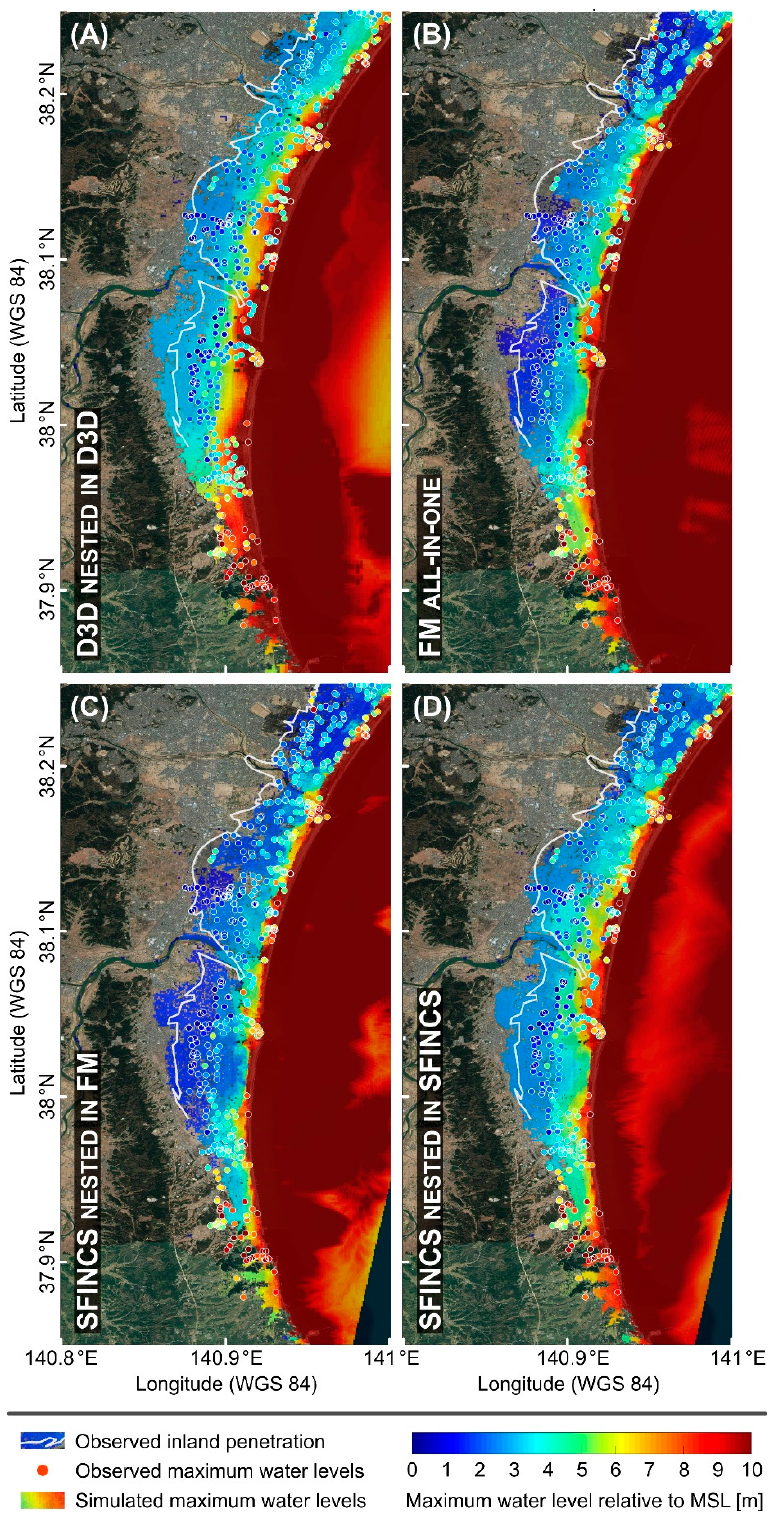
Figure 6. Map of the Sendai coast showing the maximum tsunami water levels as simulated with ( A ) the Delft3D-FLOW (D3D) reference model, ( B ) the D-FLOW Flexible Mesh (FM) model, ( C ) the nested SFINCS model forced by the FM model and ( D ) the nested SFINCS model forced by the overall SFINCS model (coloured patches) and as derived from 620 observed high water marks (coloured dots; corrected for tidal elevations) according to [23,33] for the 2011 T ō hoku tsunami. The white line indicates the observed inland penetration, i.e., the maximum onshore inundation extent.